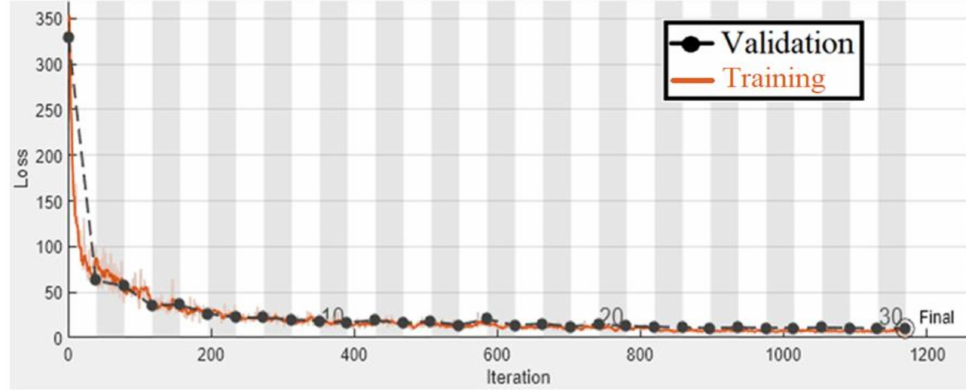
Figure 15. Training and validation loss plot of the eye gaze direction estimation model.